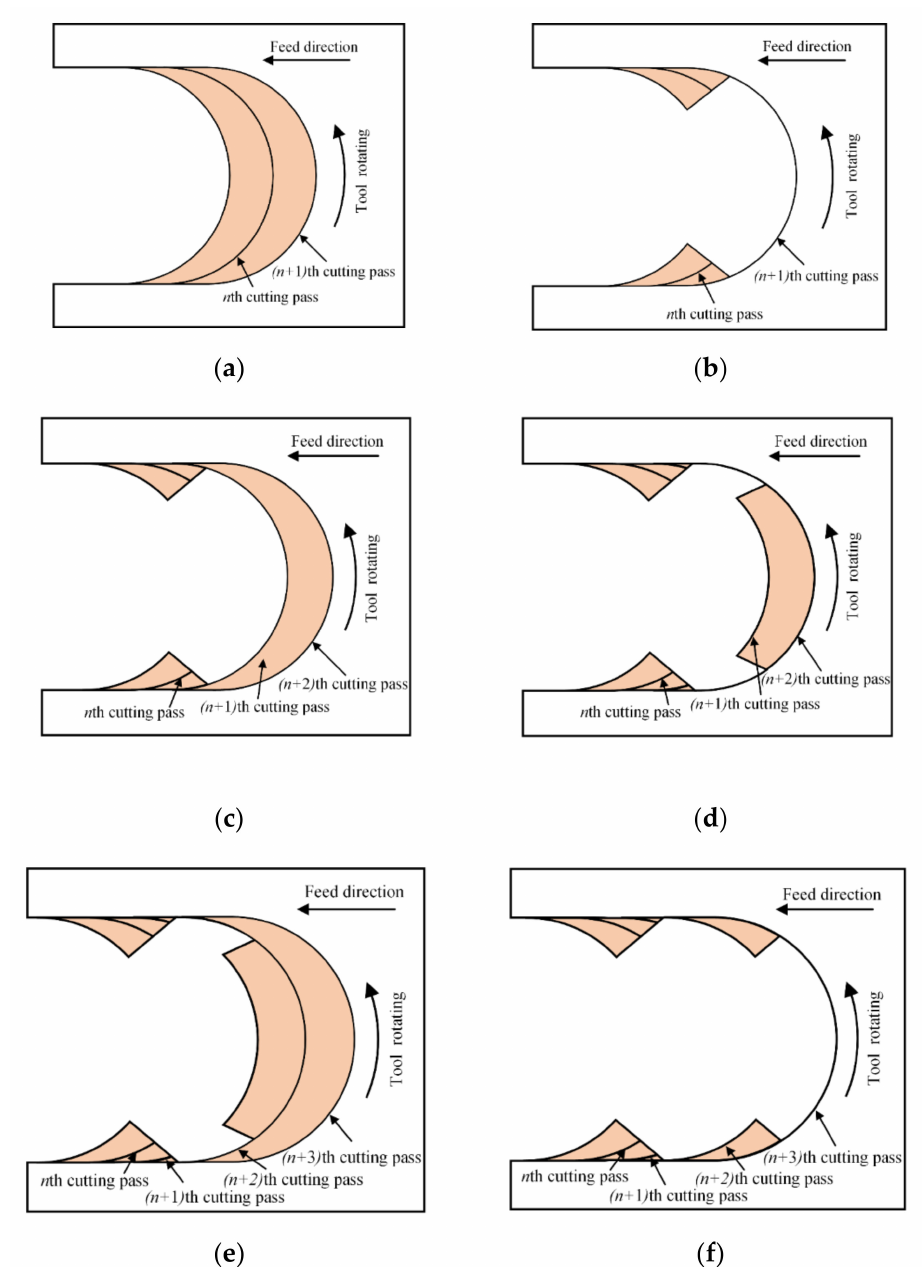
Figure 5. The e ff ect of the minimum undeformed chip thickness on cutting process: ( a ) the n th cutting pass, ( b ) the ( n + 1)th cutting pass, ( c ) the residual material in the ( n + 2)th cutting pass, ( d ) the material removal in the ( n + 2)th cutting pass, ( e ) the residual material in the ( n + 3)th cutting pass, ( f ) the material removal in the ( n + 3)th cutting